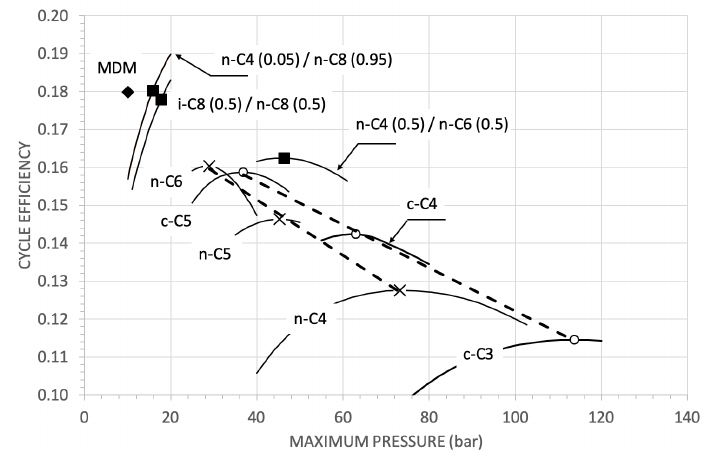
Figure 6. Thermodynamic cycle efficiency as a function of the maximum pressure.